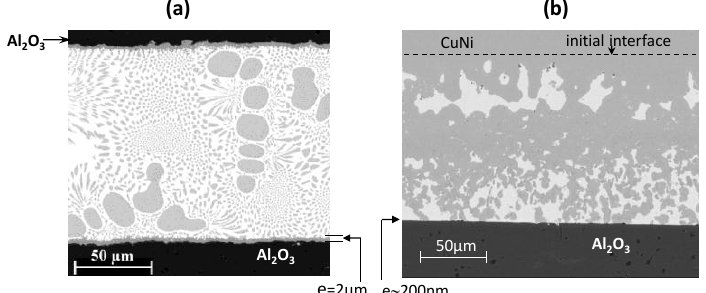
Figure 20. Cross-sections of ( a ) alumina to alumina and ( b ) alumina to CuNi plates. Assemblies brazed by a CuAg-Ti alloy (900 °C, 15 min). e denotes here the thickness of Fig. 20 - Cross-sections of (a) alumina to alumina and (b) alumina to CuNi plates. Assemblies brazed by a CuAg-Ti alloy (900°C, 15 min). e denotes here the thickness of the interfacial the interfacial reaction product. According to reaction product. According to [42].